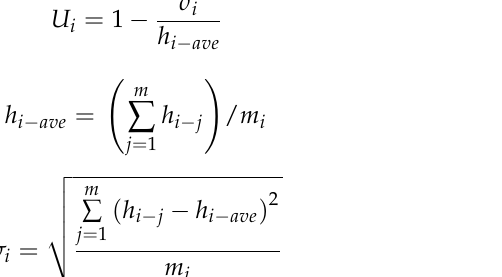
Figure 8. Variation of solidified shell at the center of: ( a ) wide face, ( b ) narrow face under different EMS